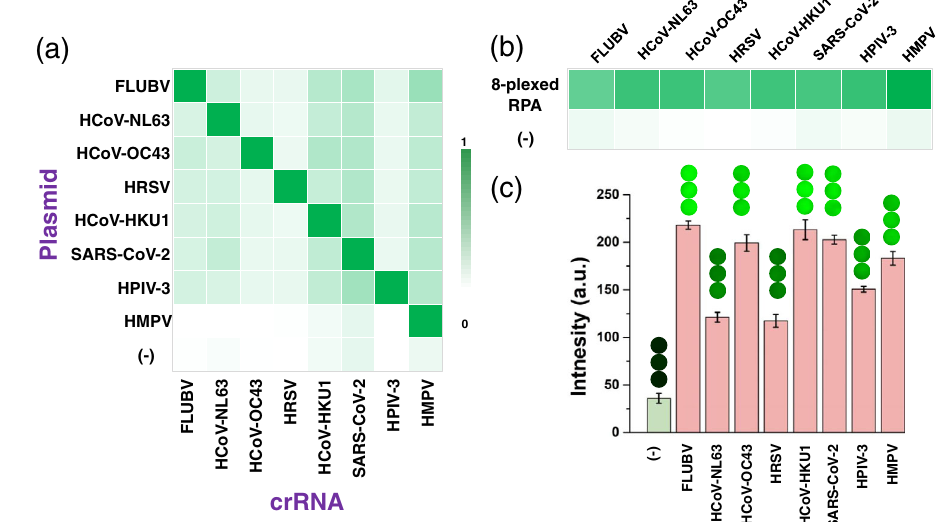
fi le. c MiCaR-based readout to evaluate the 8-plexed RPA assay. ( − ) was used as Control, in which no crRNA was added. To be noted, the amplicons used in b and c were from different batches of RPA assays. Values represent the mean±SD and n =3 biologically independent experiments. Source data are provided as a Source Data fi